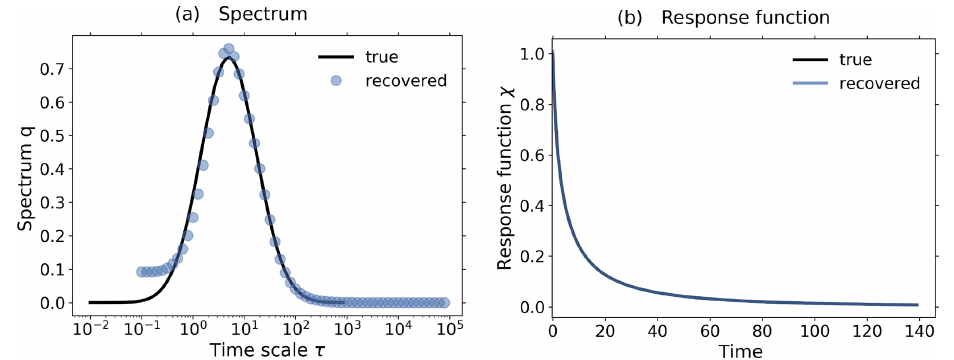
Figure E2. Response function χ(t) and spectrum q λ recovered from toy model data taking the RFI parameters M = 60, log τ min = − 1, and log τ max = 5. Blue dots in (a) and blue line in (b) indicate the recovered values for the spectrum and for the response function, while black lines indicate their “true” values.